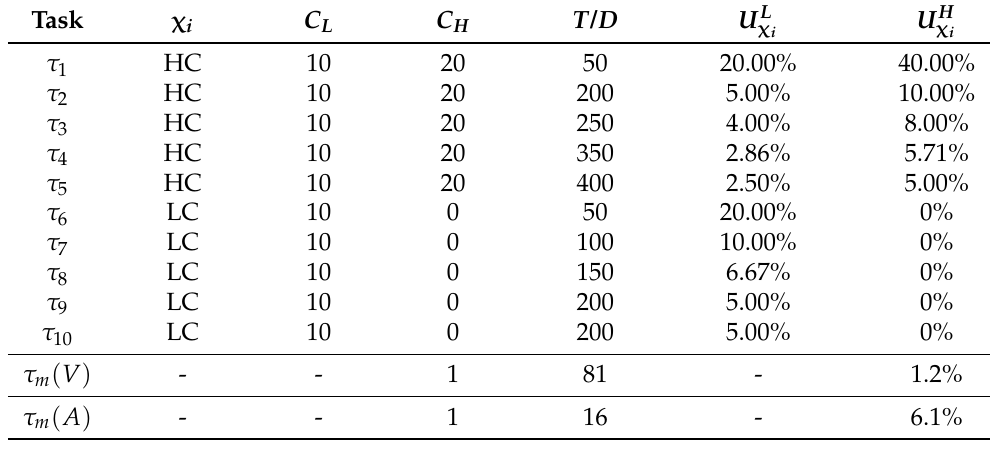
Table 2. MC Task System for DMC (time unit: ms).